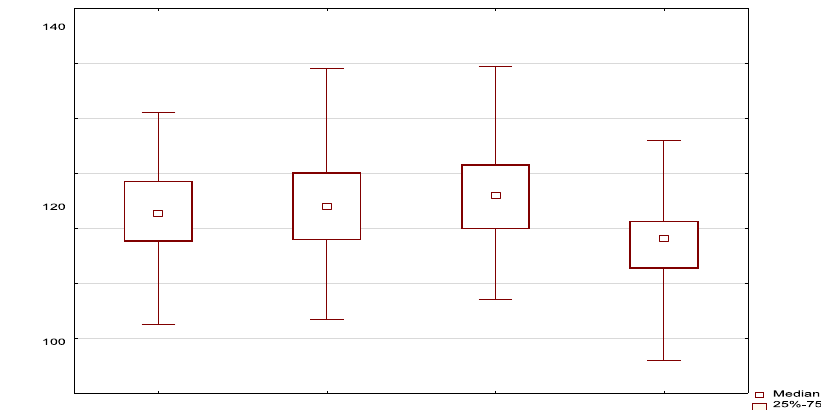
Note: Sample n = 441. Figure 1. Passivity in the populations studied